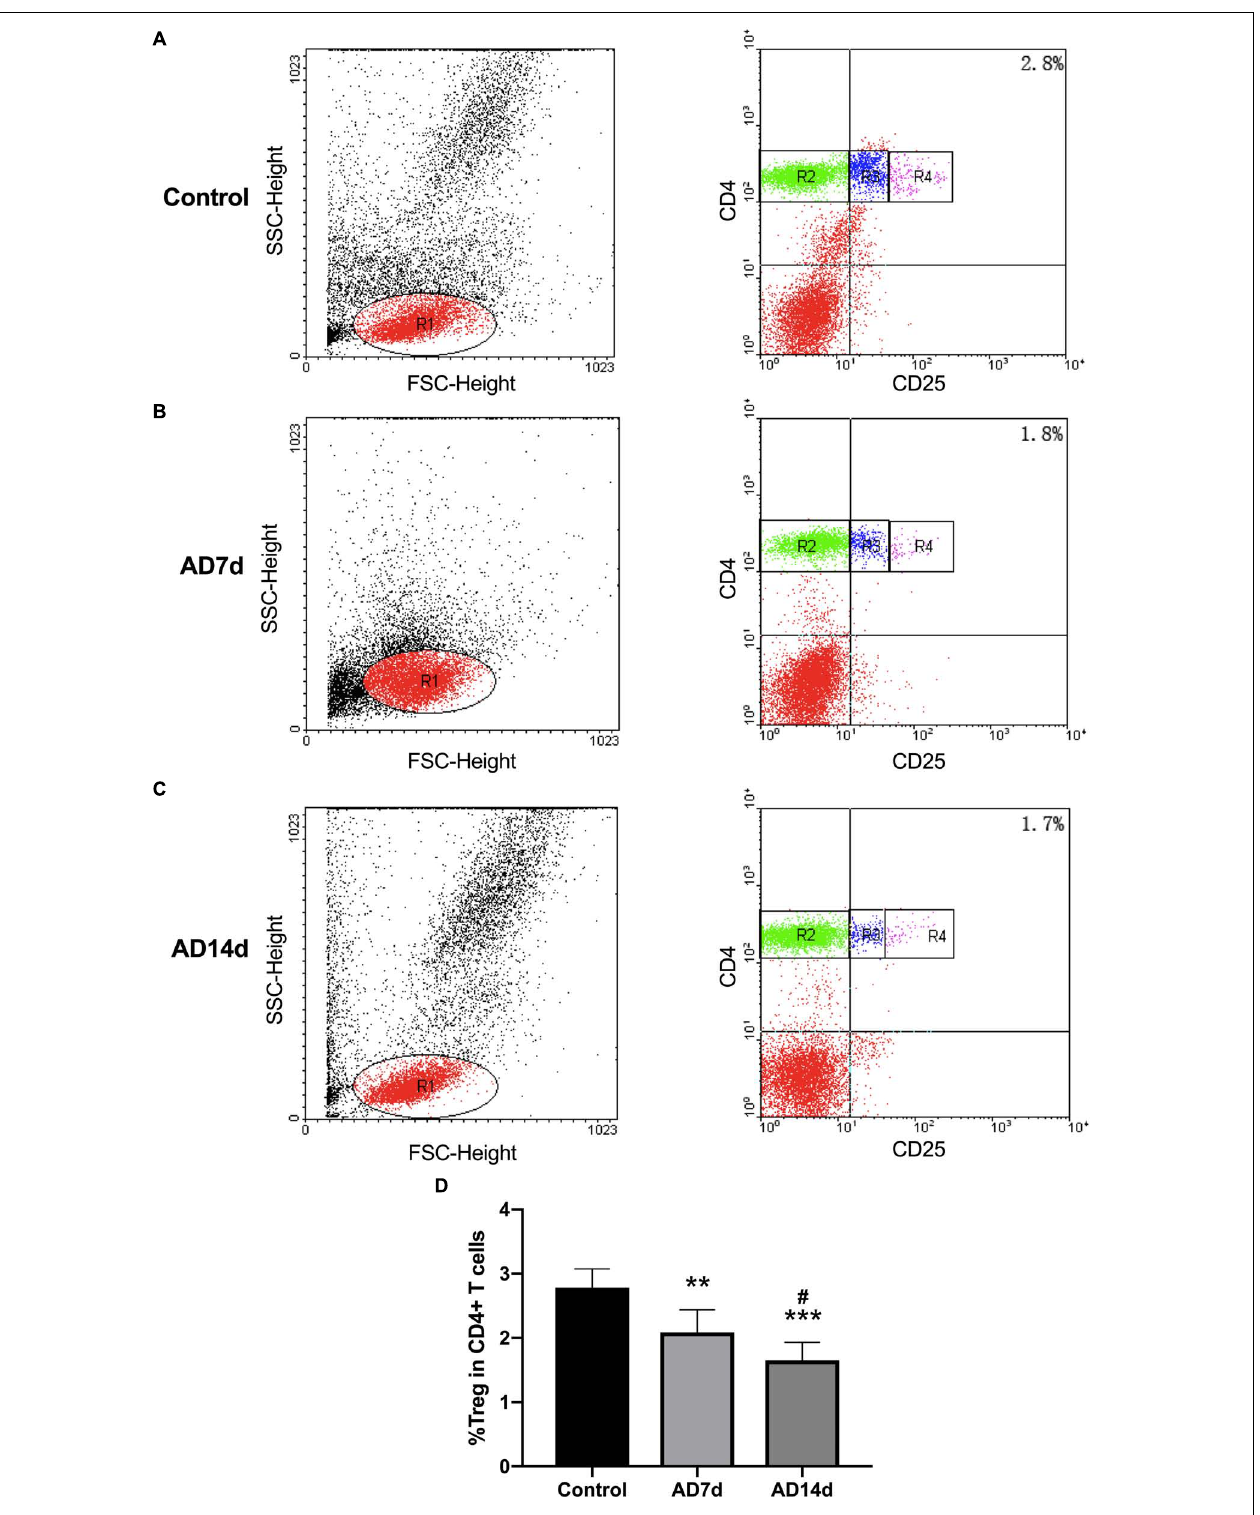
FIGURE 7 | Reduced circulating Tregs populations in AD rats. The population of Tregs, as a subset percent of total CD4+ cells, was estimated with use of flow cytometry. Dot plots shown are representative of rats in the Control (A) , AD7d (B) , and AD14d (C) groups. Tregs were confirmed as CD4 + CD25 high T cells. Numbers in each compartment indicate the proportion of Tregs in CD4 + cells. (D) Percent of Tregs in total CD4+ T cells in the Control, AD7d and AD14d groups. n = 9 per group, mean ± standard deviation, ∗∗ P < 0.01, ∗∗∗ P < 0.001 vs. Control group, # P < 0.05 vs. AD7d group.